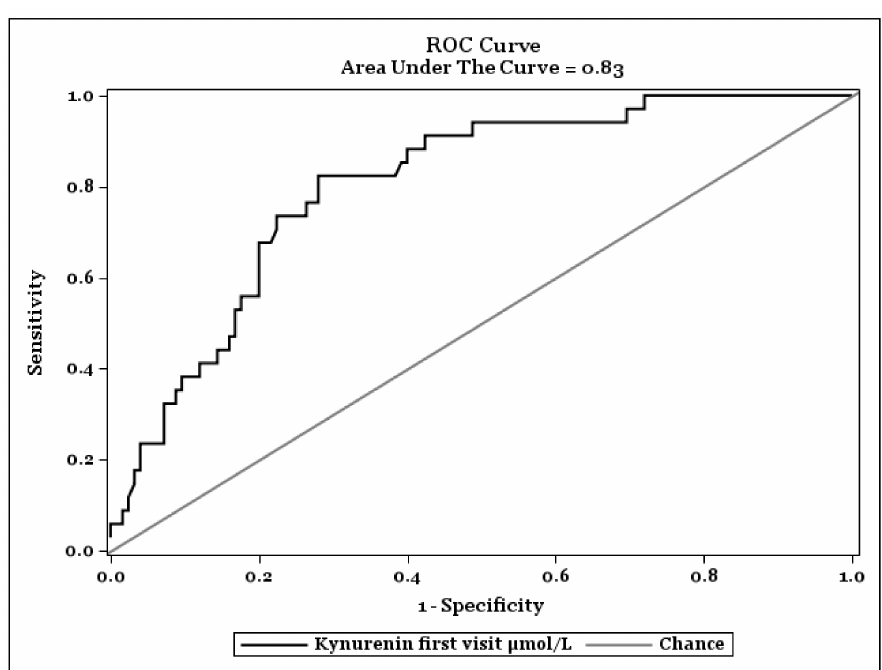
Figure 2. ROC Curve to find an optimal cut-off value of Kynurenine on progression of COVID-19.